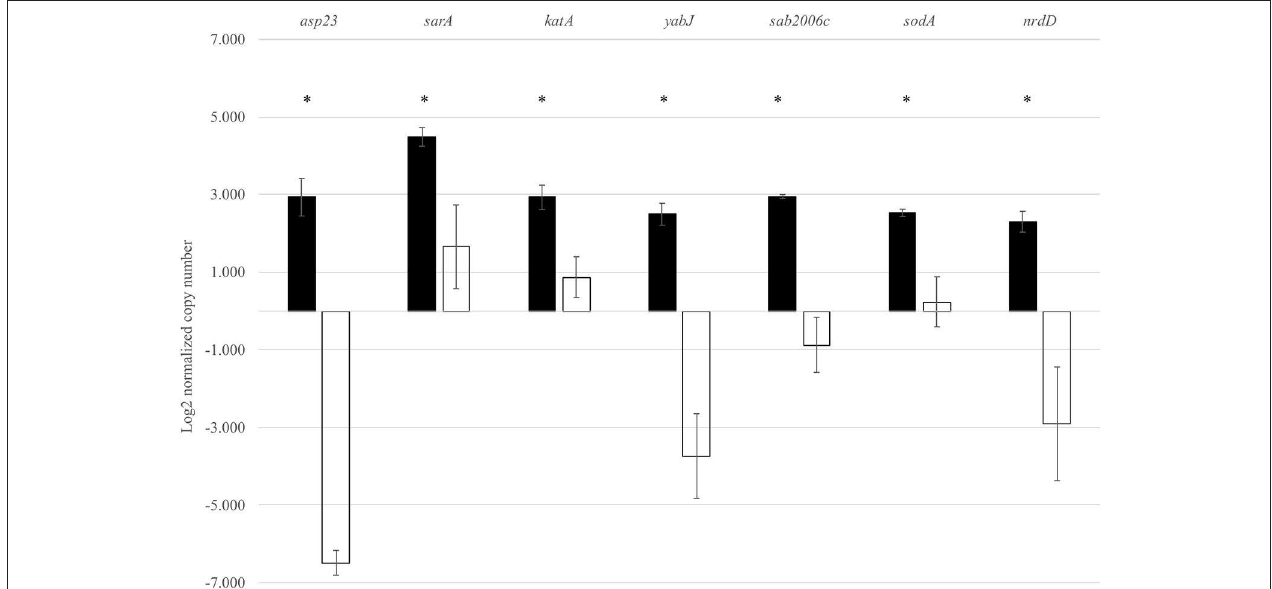
FIGURE 3 | Expression of seven selected genes in both the wild type and 1 sigB mutant determined by qRT-PCR. Differences in mRNA levels of all genes are statistically significant when compared between RF122 wild-type (black) and 1 sigB mutant (white) strains. *significant difference between wild-type and 1 sigB mutant strains at p <